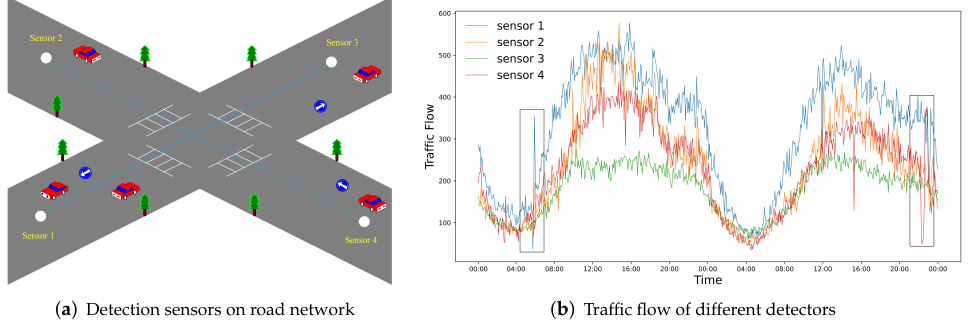
Figure 1. Example of spatiotemporal dependencies in PEMSD8 Dataset. ( a ) Global space correlation is dominated by the road network structure. ( b ) Sudden events, as marked with black boxes in the